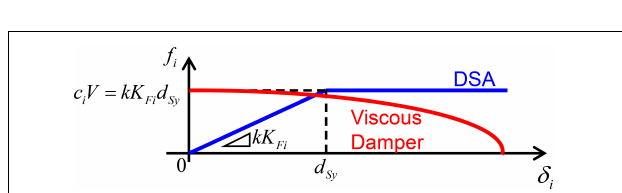
FIGURE 5 | Equivalence condition of viscous damper in HVH system and hysteretic damper (DSA) in DHD system.